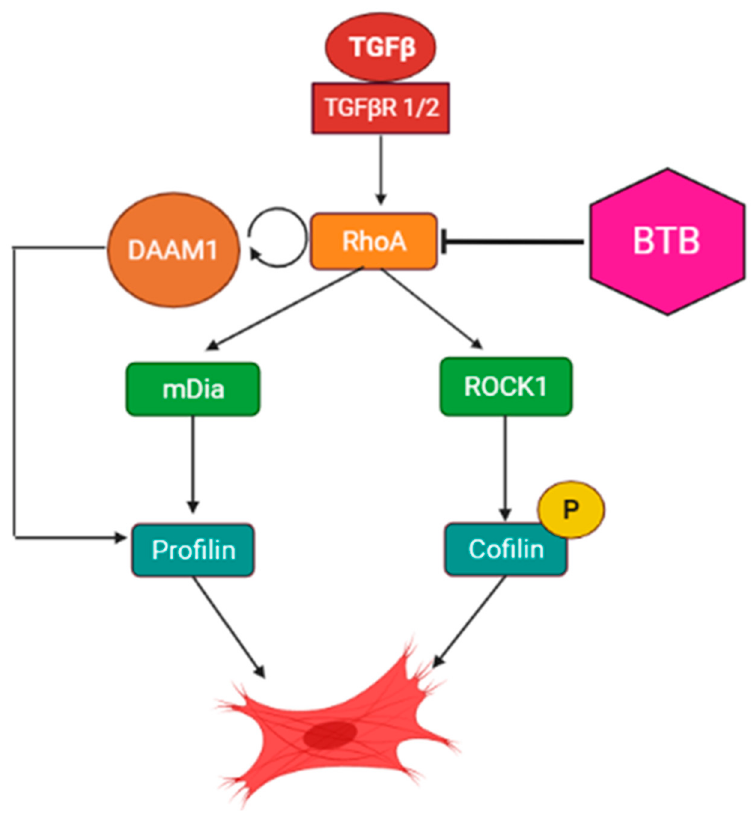
Figure 8. Schematic for the proposed mechanism of the action of BTB. BTB blocks RhoA activation, in part through inhibition of DAAM1. This leads to inhibition of both ROCK1 and mDia signaling, which prevents myofibroblast differentiation.